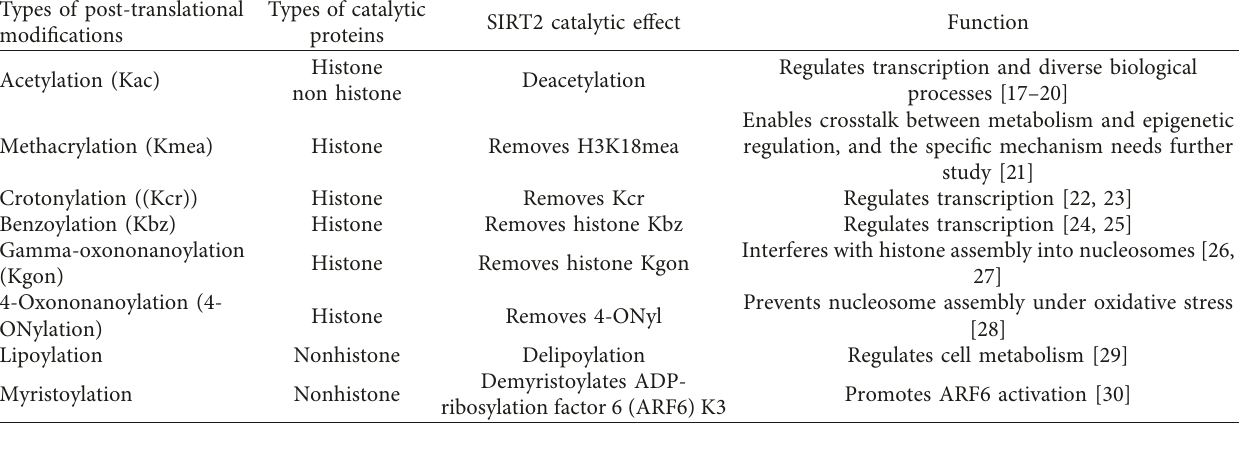
Table 1: Posttranslational modifications involving SIRT2.